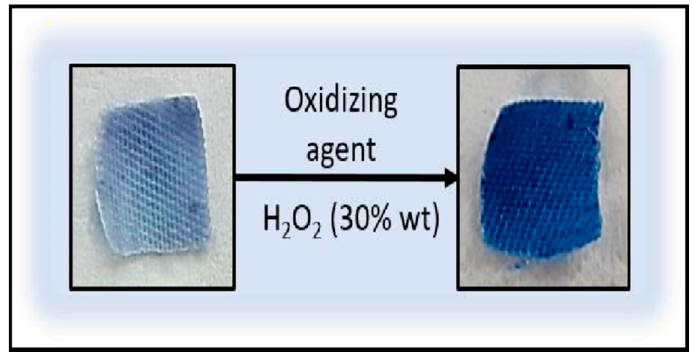
Figure 5. Reversibility assays after 24 h of bacterial